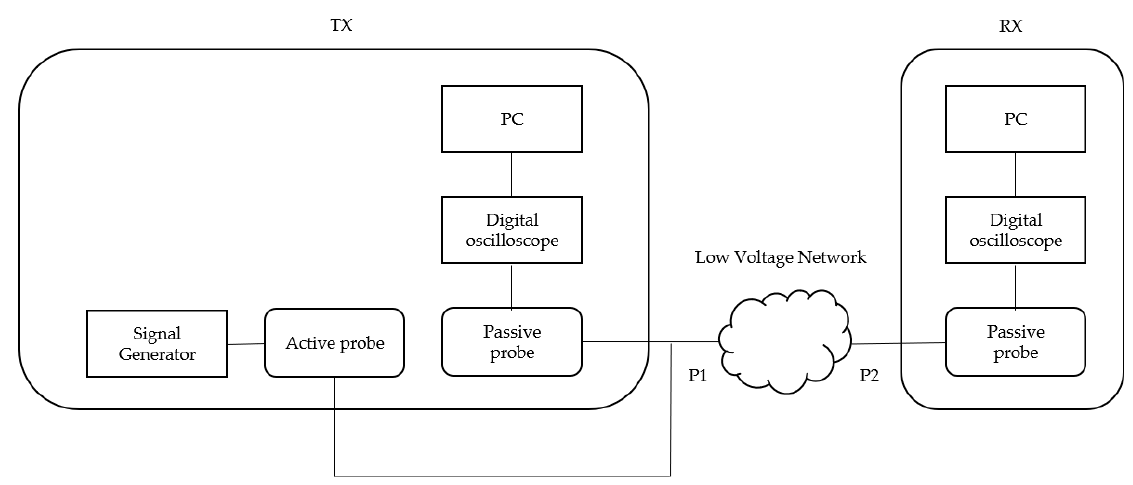
Figure 1. Measurement system for the assessment of the transmission losses.